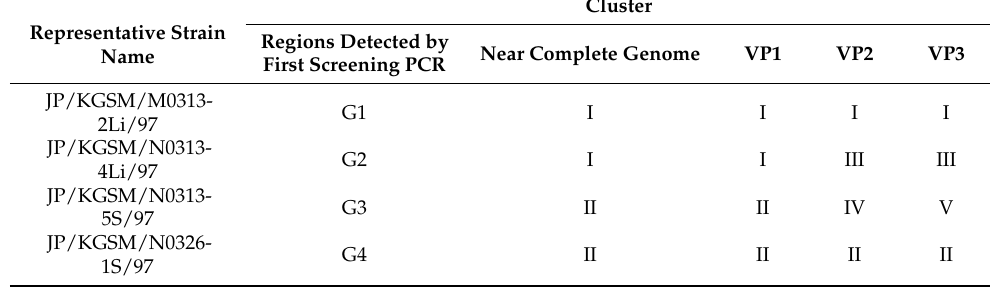
Table 4. Summary of classification based on different genetic regions.